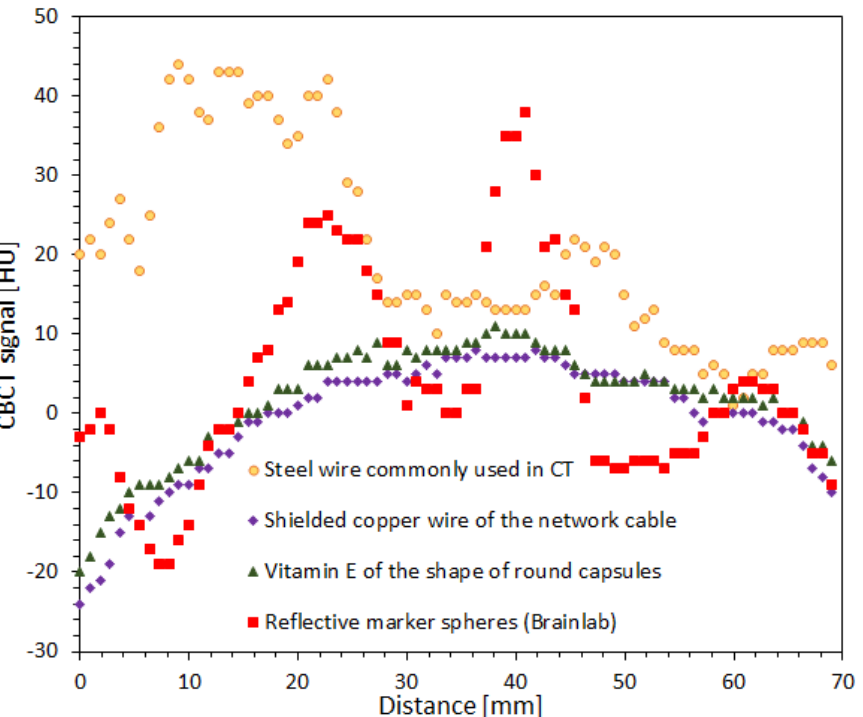
Figure 5. Comparison of profiles randomly drawn across each scanned container with different markers, as indicated in Figure 4B.